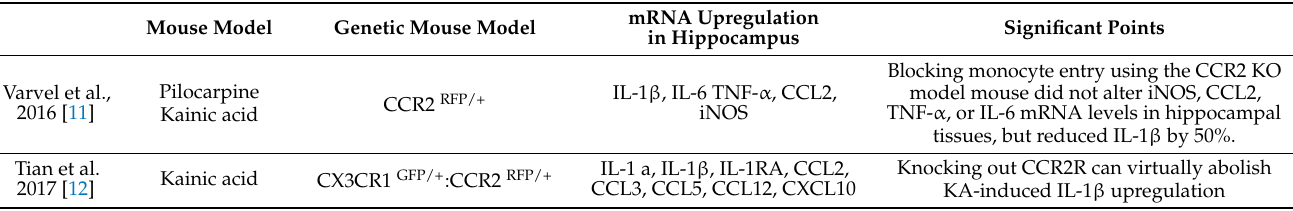
Table 2. Immune profiles in representative mouse